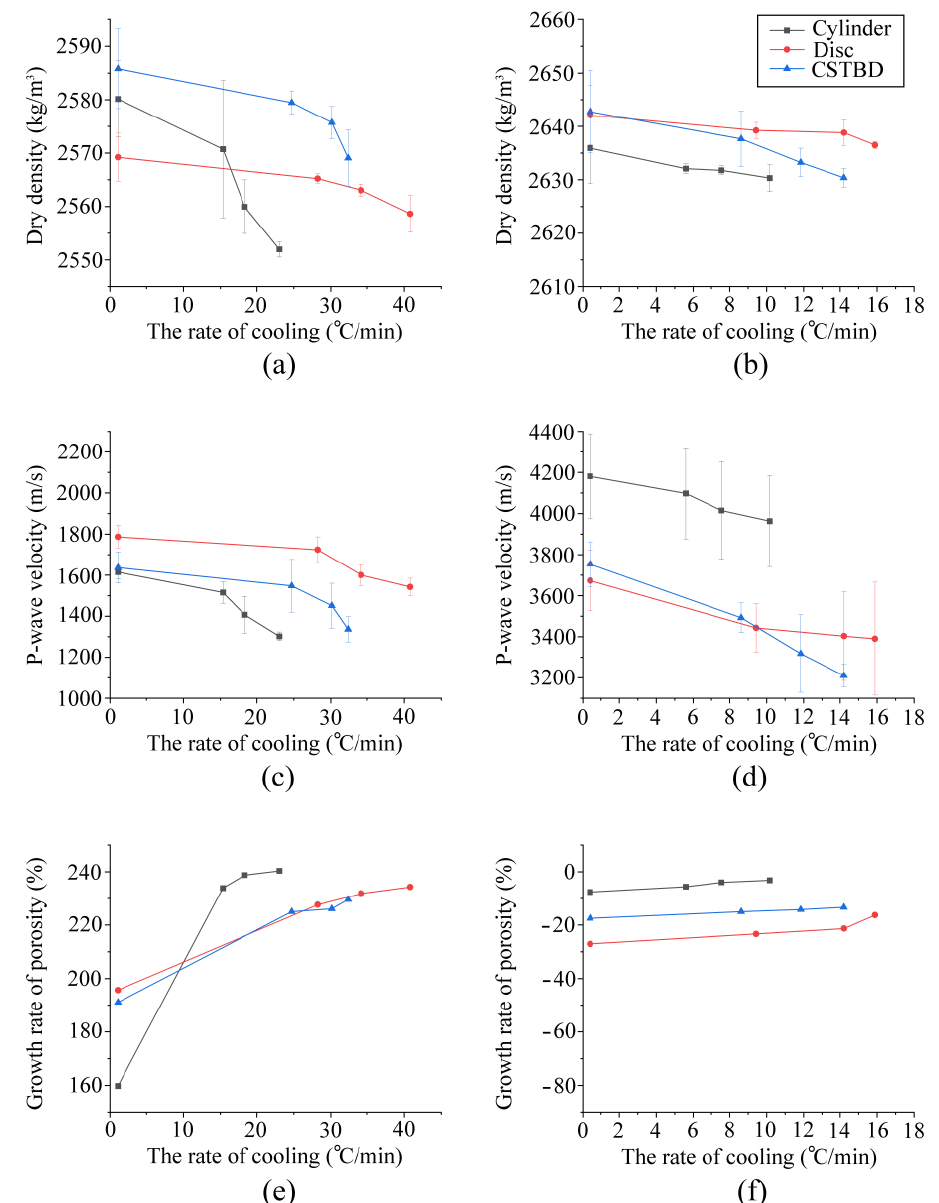
Figure 6. Variation of physical properties of granite specimens with cooling rates: ( a , c , e ) after heating at 500 °C; ( b , d , f ) after heating at 200 °C (error bars represent standard deviation).